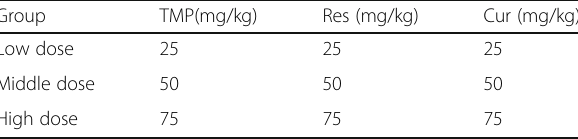
Table 4 The three dose group of TRC combination on CIA rats